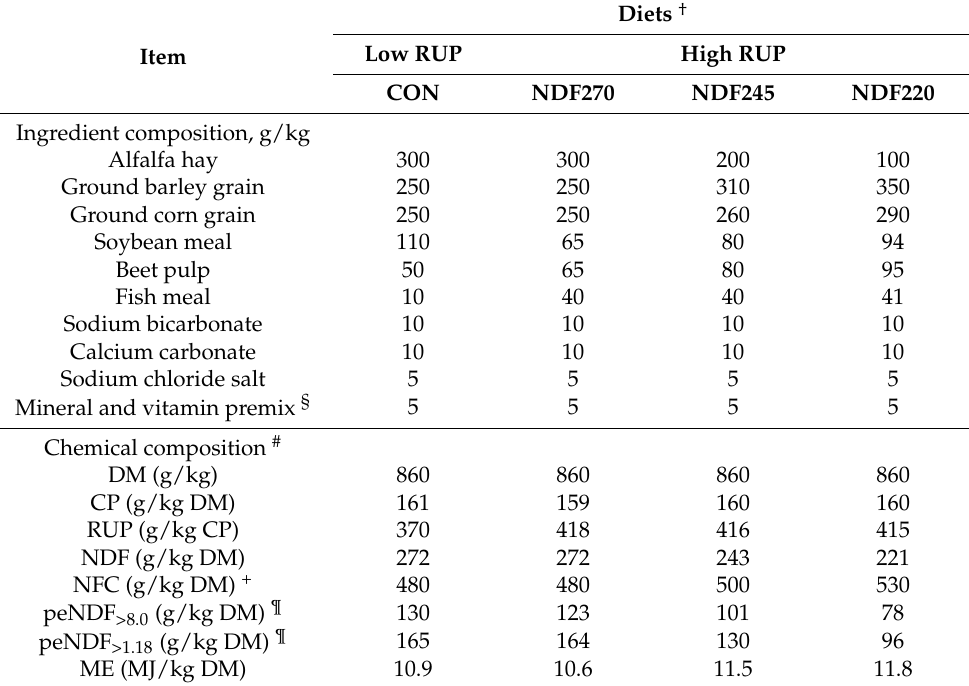
Table 1. Ingredients and chemical composition of experimental diets (DM